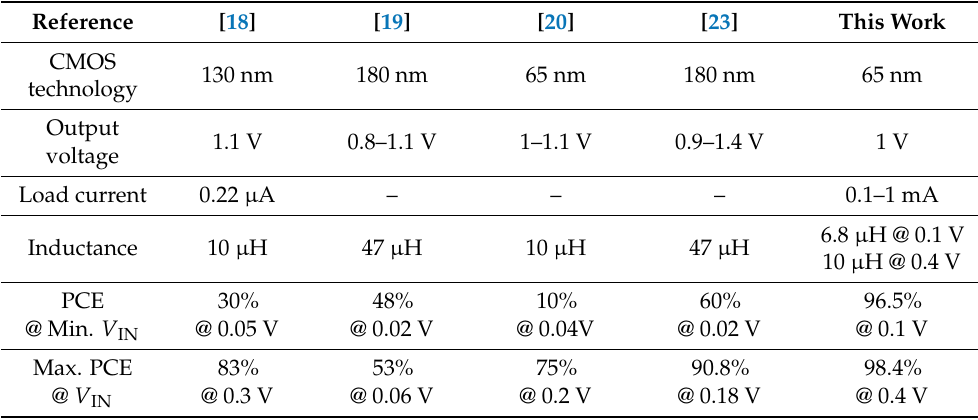
Table 1. Performance summary and comparison.